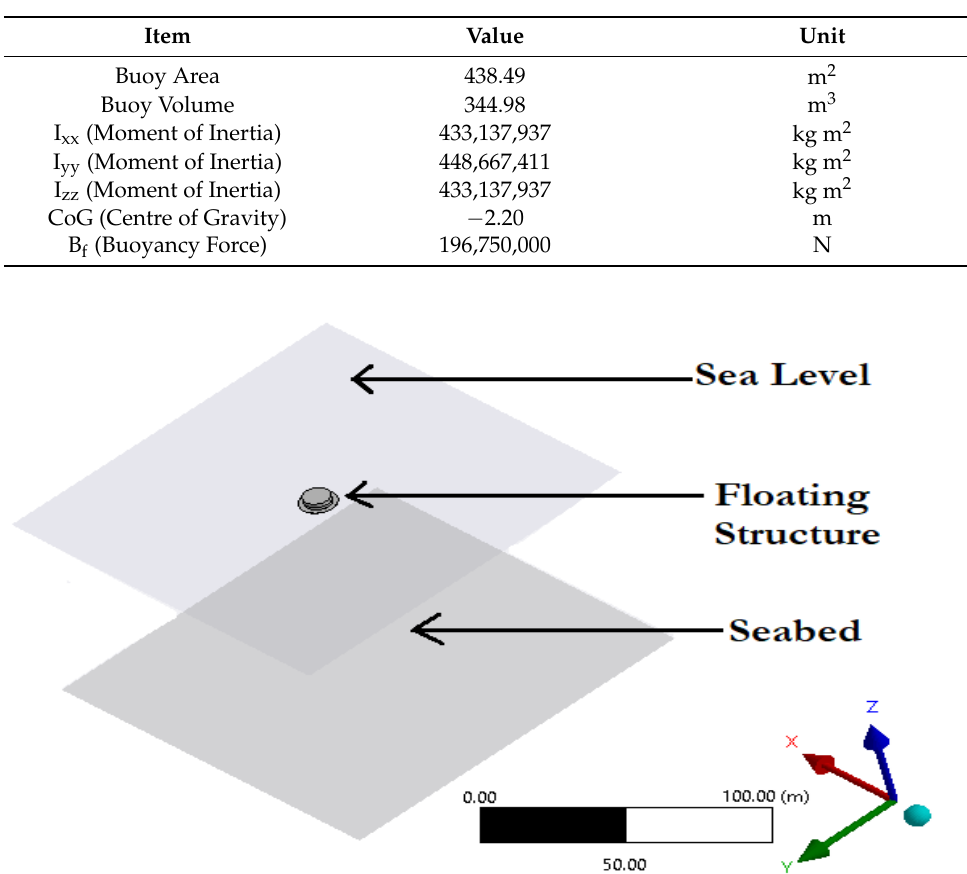
Figure 15. Model ocean view of the free-floating CALM buoy in ANSYS AQWA R1 2021.